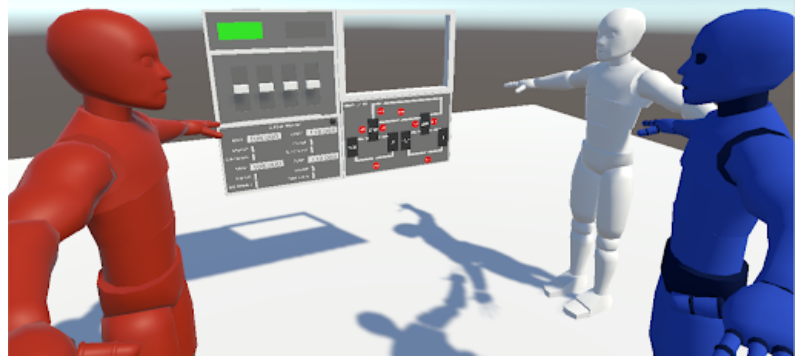
Figure 6. All users facing a MATB-II interface.